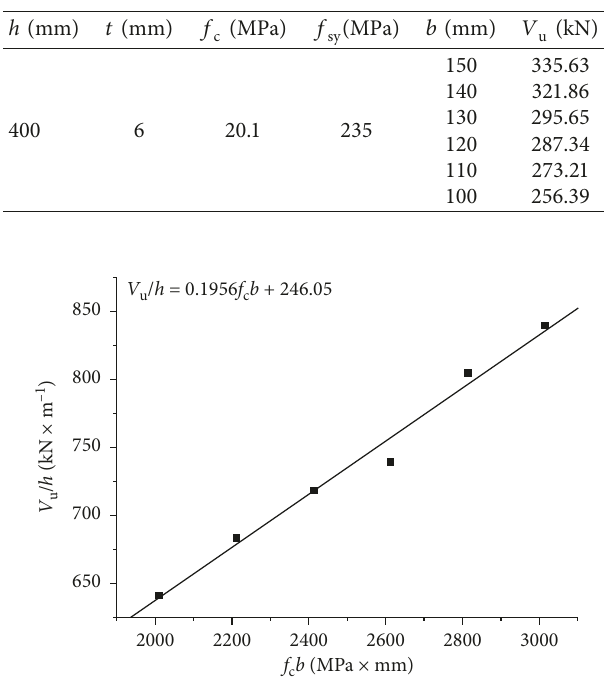
Table 4: The parameters of the example.